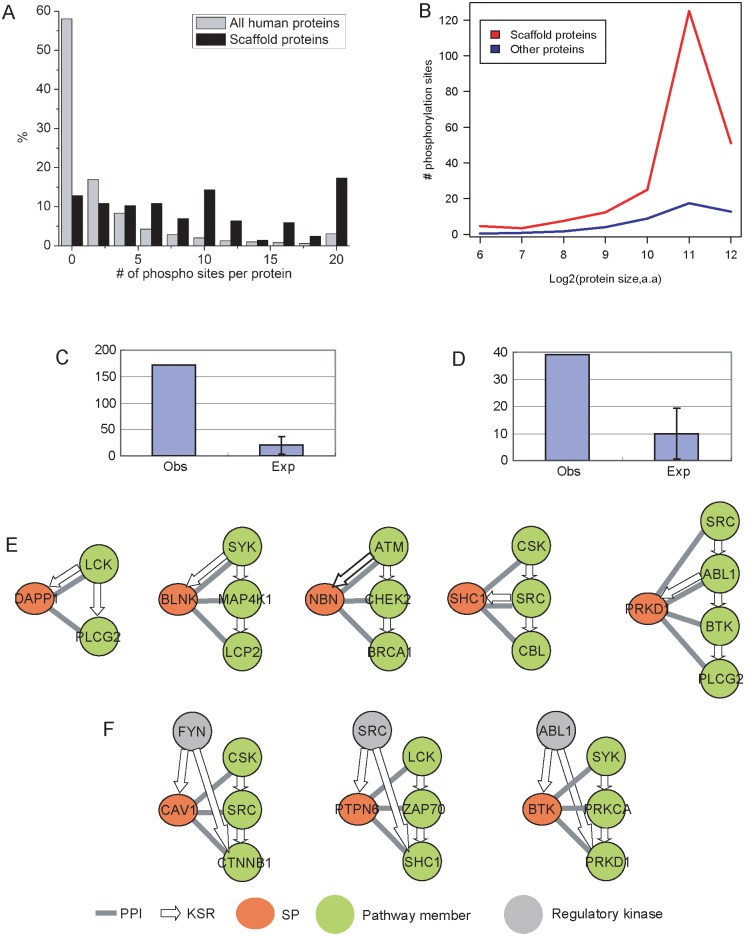
Possible regulatory mechanisms of scaffold proteins.(A) Distribution of MS/MS determined phosphorylation site numbers per protein. Predicted scaffold proteins have 12 sites on average. As a contrast, proteins in human proteome only have 2 sites on average. (B) The high number of phosphorylation sites in scaffold proteins is not due to larger protein sizes. If we compared the number of sites between scaffold proteins and the proteins with similar sizes, the similar observation was made. One possible regulatory mechanism for scaffold proteins is that one kinase member in the pathway phosphorylates the scaffold protein. The number of such cases is shown in (C). The examples are shown in (E). The second possible mechanism is that one upstream kinase phosphorylates both scaffold protein and one member in the pathways. The number of such cases is shown in (D). The examples are shown in (F).